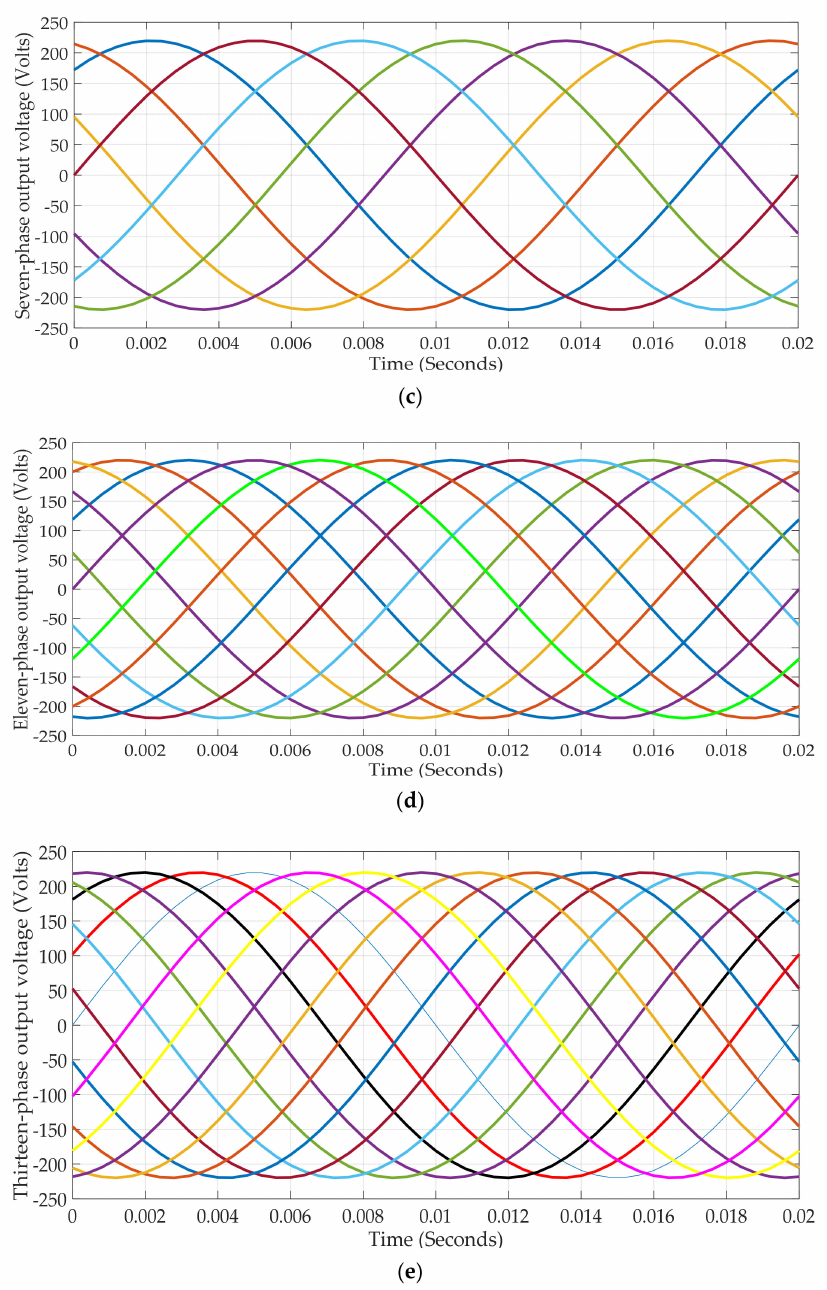
Figure 10. ( a ) Three-phase input and output voltage waveforms of three-phase to ( b ) five-, ( c ) seven-, ( d ) eleven-, and ( e ) thirteen-phase